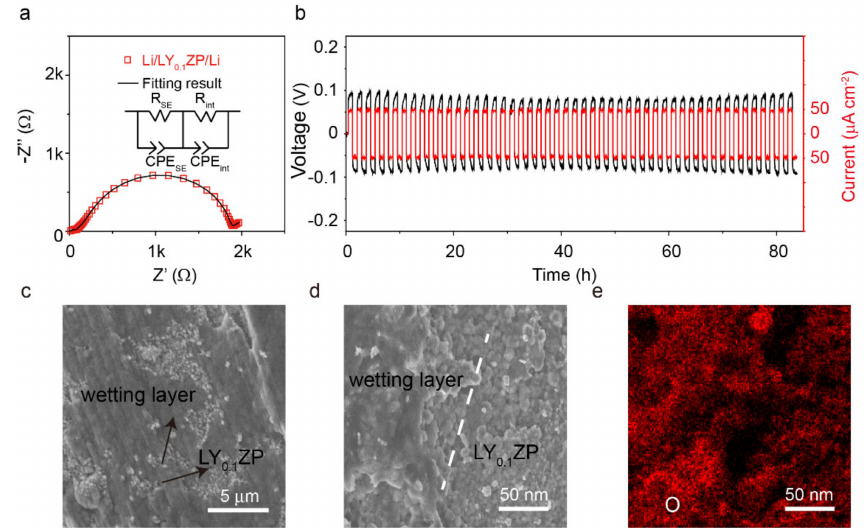
Figure 4. ( a ) Impedance plot of a symmetric Li / LY0.1ZP / Li cell tested at 60 ◦ C; the applied frequency for the symmetric cell was 1 MHz–1 Hz. ( b ) The cycling stability of LY0.1ZP electrolytes in a symmetric Li / LY0.1ZP / Li cell at 0.05 mA cm − 2 at 60 ◦ C. ( c ) The top view and ( d ) cross-section images of LY0.1ZP after contacting with lithium metal. ( e ) The mapping of O element on cycled LY0.1ZP. Scale bar: 50 nm; the size of the Li foil was 0.5 cm − 2 .